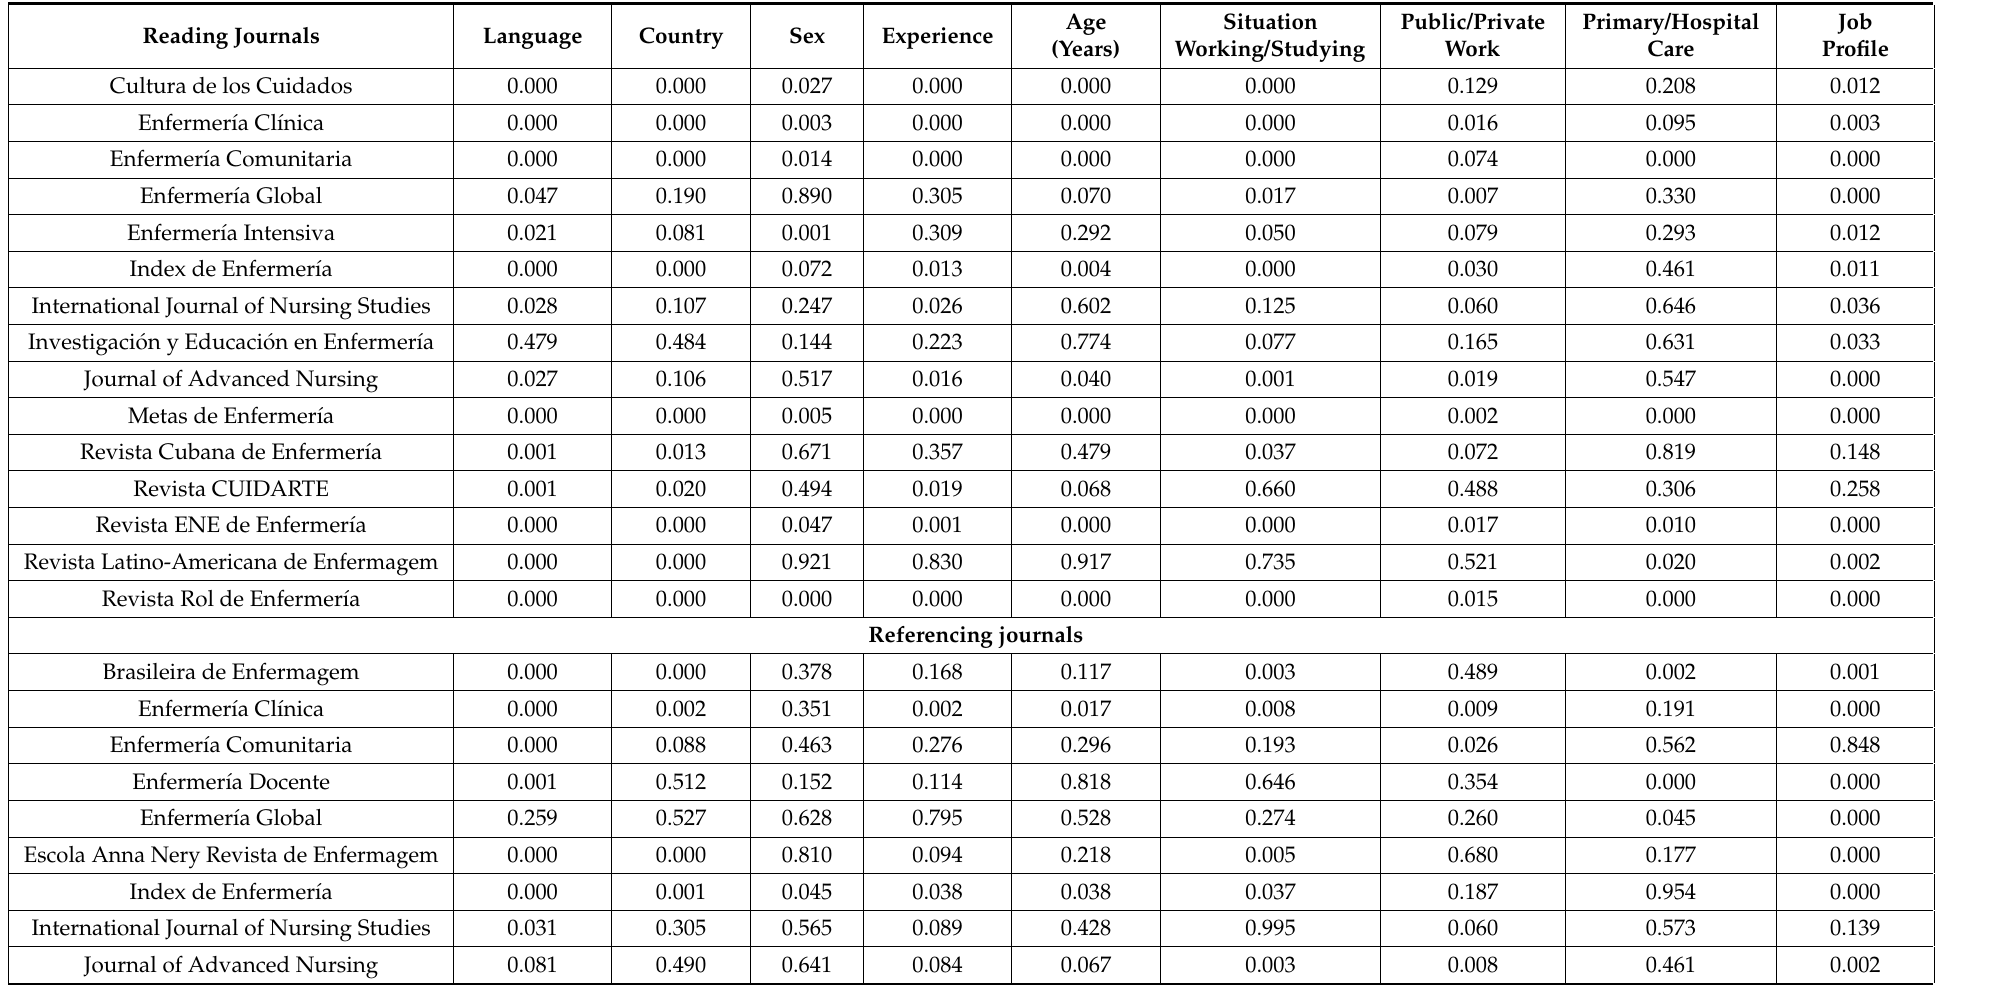
Table 2. 1Q_LcEE-CAPC Questionnaire. Contrast of hypotheses, demographic variables, and responses to “knowing and not knowing the top 10 journals in Spanish, Portuguese, and English”. Source: